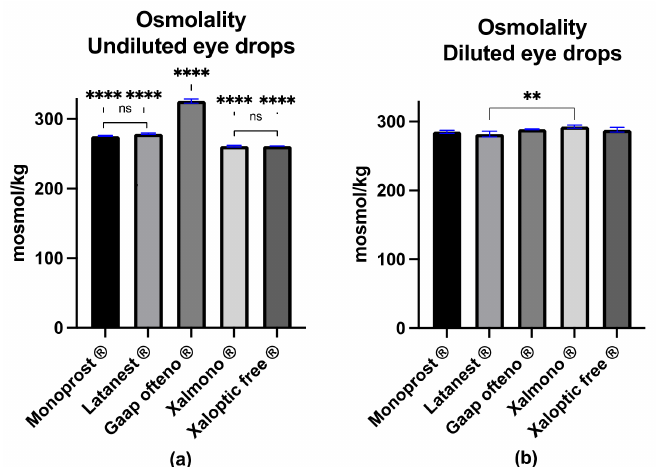
Figure 2. Osmolality characterization of preservative-free 0.005% latanoprost eye drops Monoprost ® , Latanest ® , Gaap Ofteno ® , Xalmono ® and Xaloptic ® Free: ( a ) osmolality of the undiluted eye drops; ( b ) osmolality of the diluted eye drops (1:7, v / v ). Values are listed as mean ± SD, and n = 3. A one- way ANOVA with a Tukey multiple-comparison test ( p = 0.05) was performed. ns = not significant with p ≥ 0.05, ** p ≤ 0.01, **** p ≤